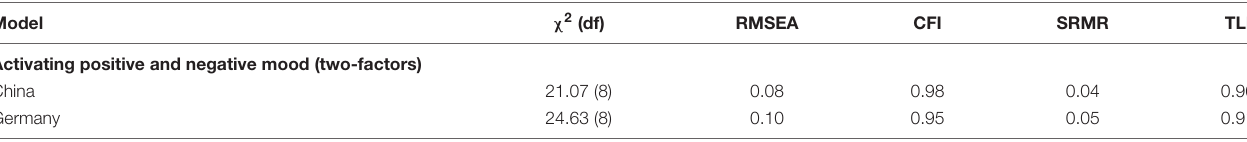
TABLE 1.2 | CFA results for the pooled sample of the activating moods during lockdown based on a split sample. Model